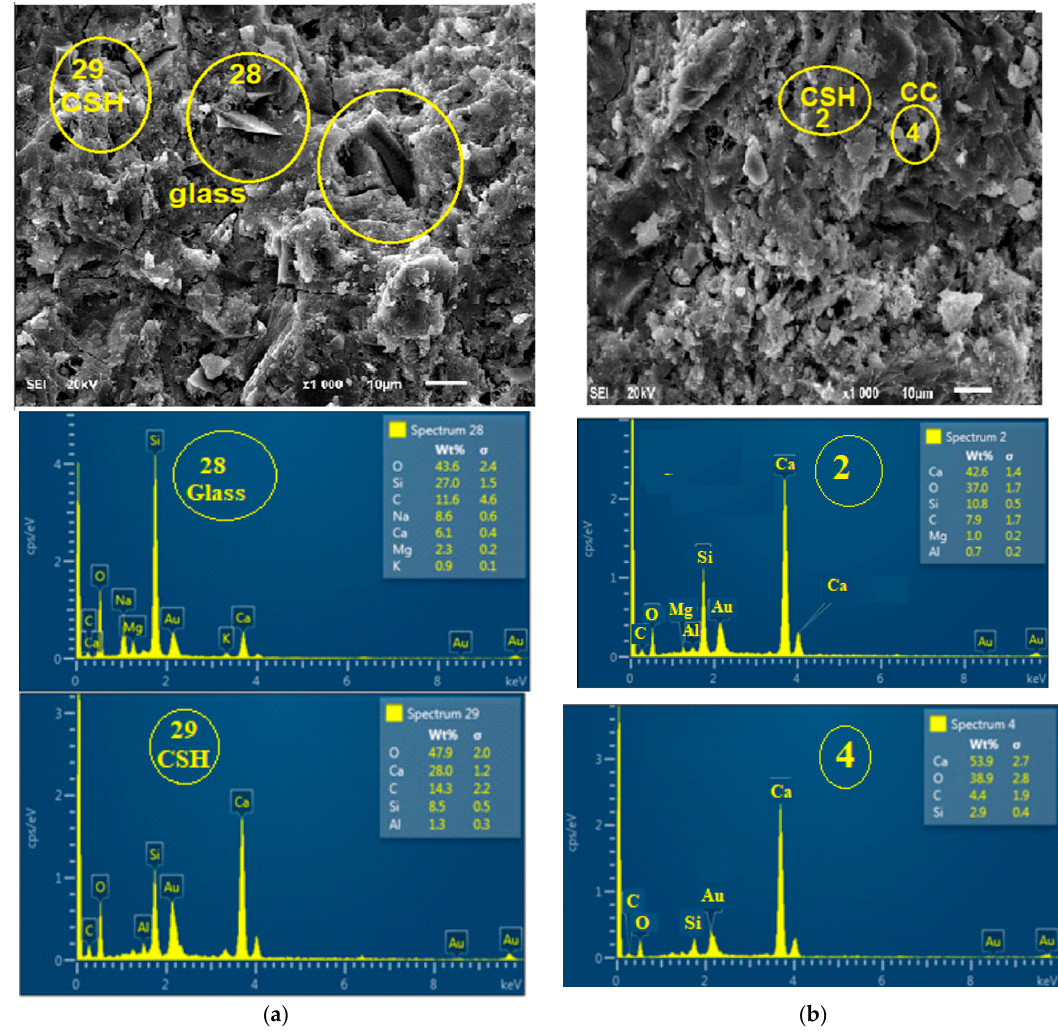
Figure 12. ( a ) Morphology of glass powder blended paste, ( b ) Morphology of ordinary Portland cement paste (Calcium silicate hydrate (CSH), Calcium silicate (CC)).